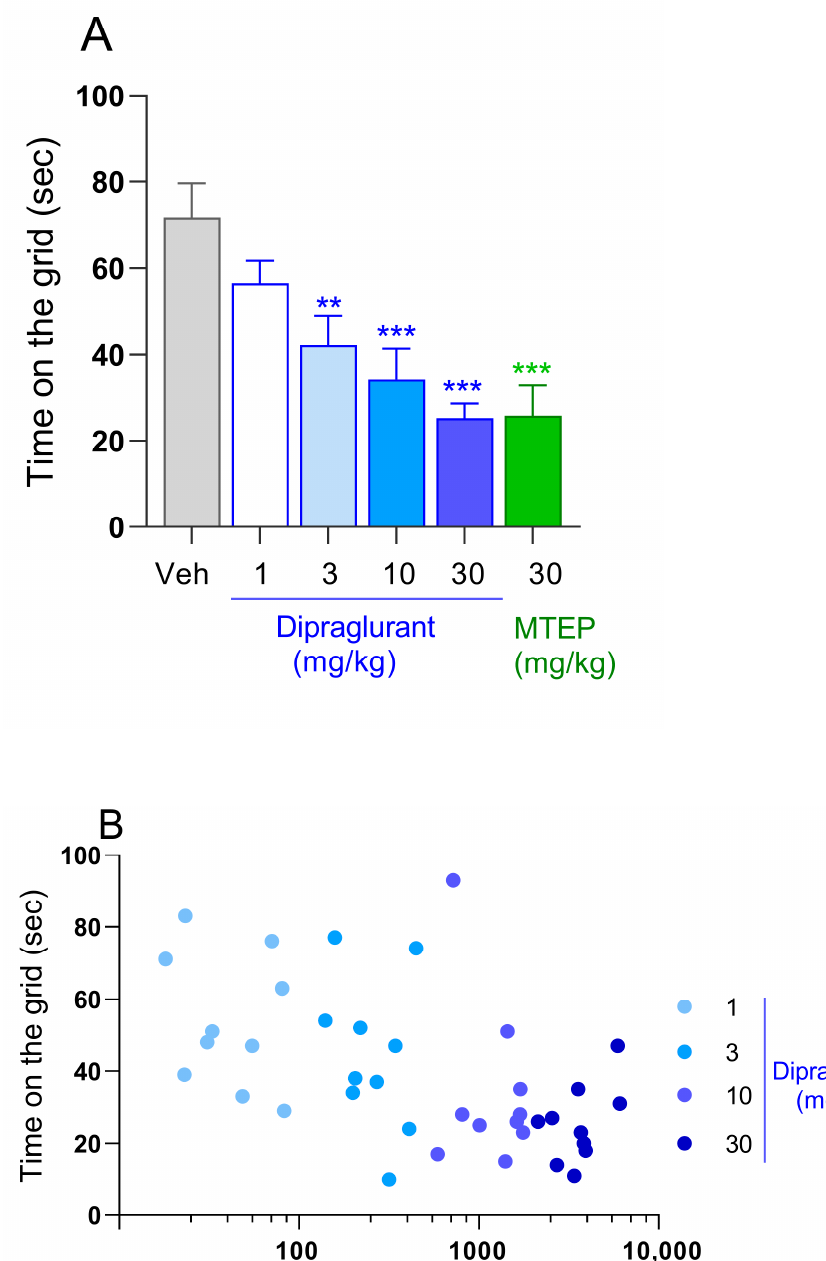
Figure 2. ( A ) Time spent by Sprague-Dawley rats ( n = 10/group) on the vertical grid during the haloperidol-induced catalepsy test. Animals were pretreated with haloperidol (1 mg/kg, i.p.) before receiving either dipraglurant (1, 3, 10, 30 mg/kg p.o.), vehicle (distilled water, p.o.) or MTEP (30 mg/kg, i.p.) and then placed on the grid. Each point represents the observed mean ± SEM, ** p < 0.01, *** p < 0.001 compared to Vehicle (Veh). ( B ) Pharmacokinetic-pharmacodynamic relation between plasma concentration of dipraglurant and time on the grid. Each point represents individual ani- mals.